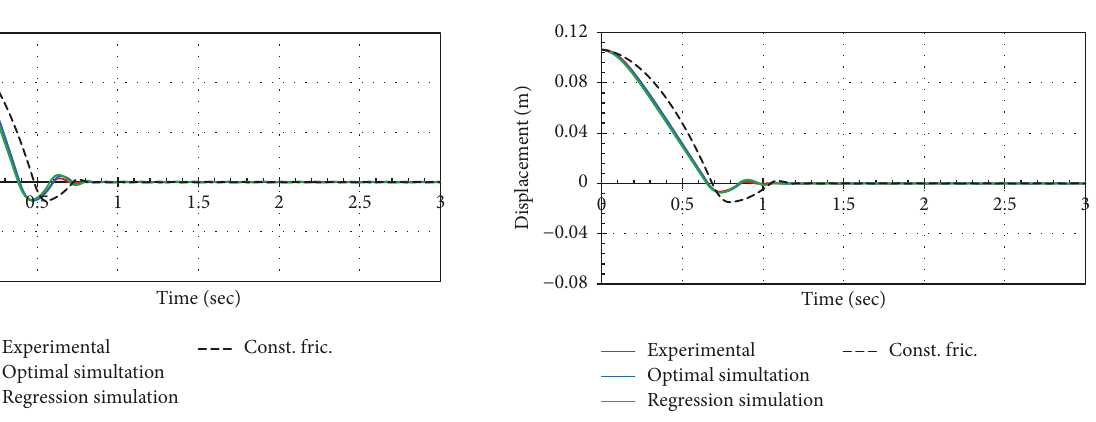
Figure 13: Simulation time history of displacement for the fric- tion function of measuring displacement and individual best fit and overall best fitting function (without lubrication with initial displacement of 54.05 mm).